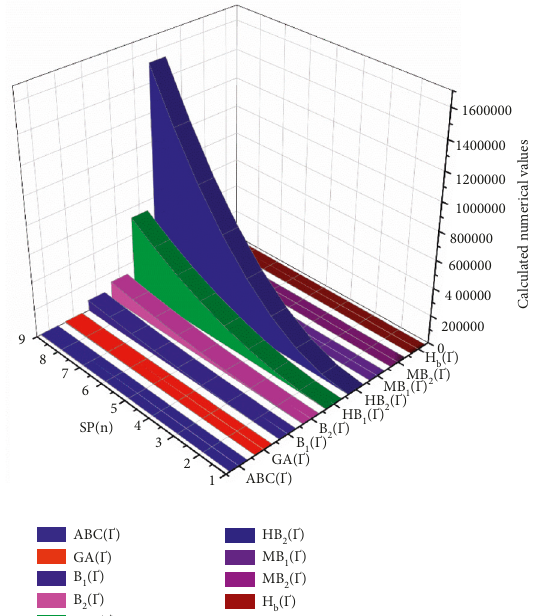
Figure 4: 3D visualisation of Table 3.